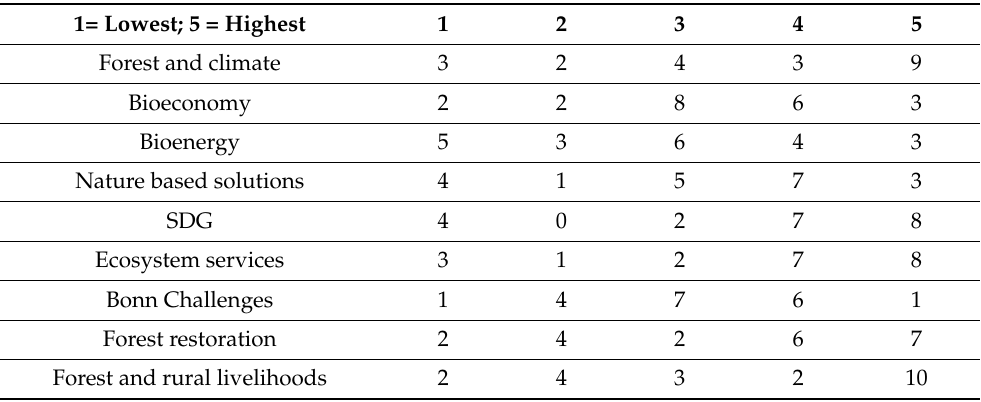
Table 4. Ranking of the extent to which issues on international agendas linked to forestry are addressed in classes provided by ASP lecturers (no. of